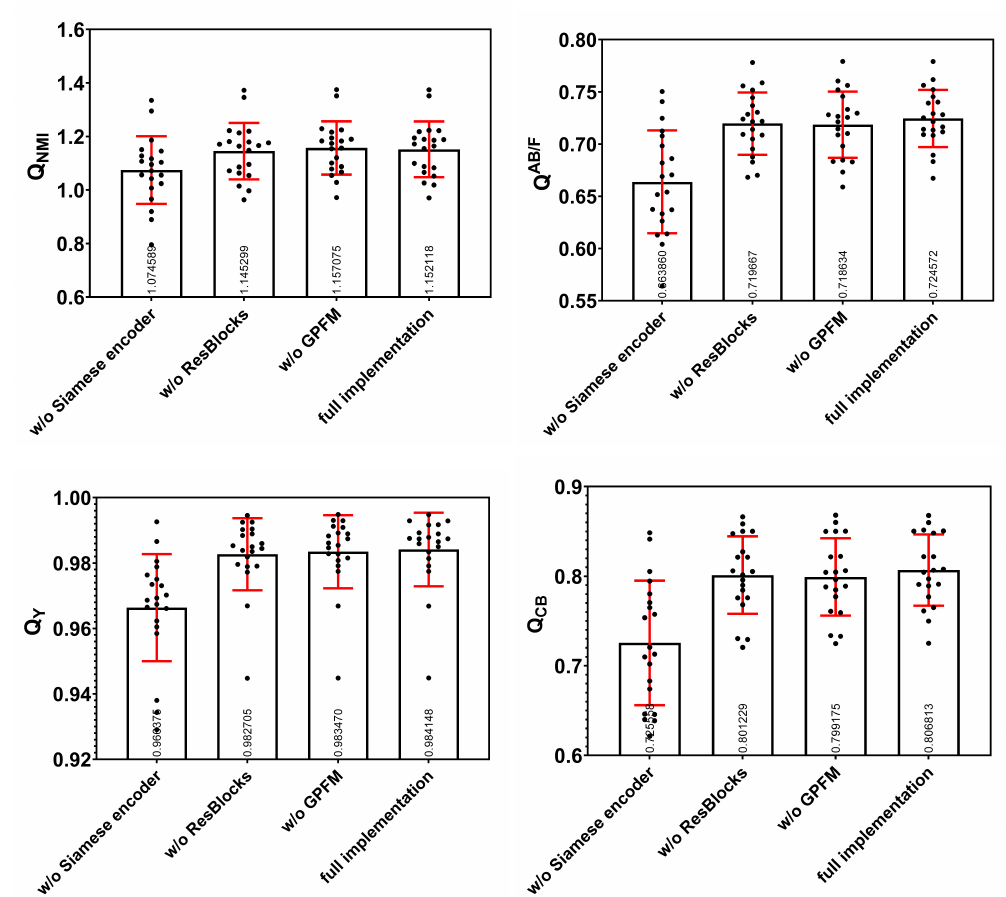
Figure A2. The quantitative results of different network architectures in the test data (20 pairs of images).